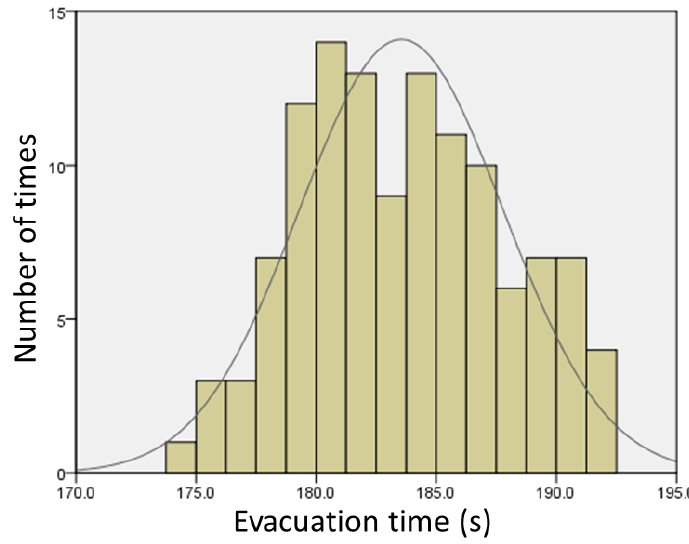
Figure 8. The results of stochastic simulation statistics on the implementation of 120 times. Table 5. Parameters of the evacuation model under the original status of the room Color scale on the right indicates the visibility. The exited number in the lower right corner of each figure represents the number of people have left this room. The occupancy capacity is 330 persons according to the official